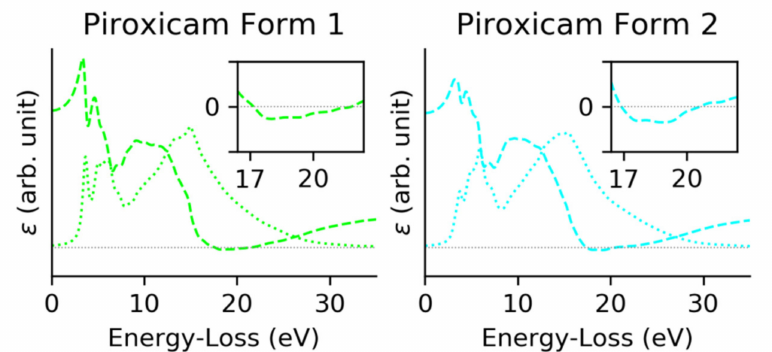
Figure 4. Complex dielectric function of monoclinic form 1 ( left ) and triclinic form 2 ( right ) phases of piroxicam. The dotted line corresponded to the imaginary part of the CDF and the dashed line to the real part. The insets corresponded to a zoom of the zero-crossing energies, (cid:60) ( ε ) =